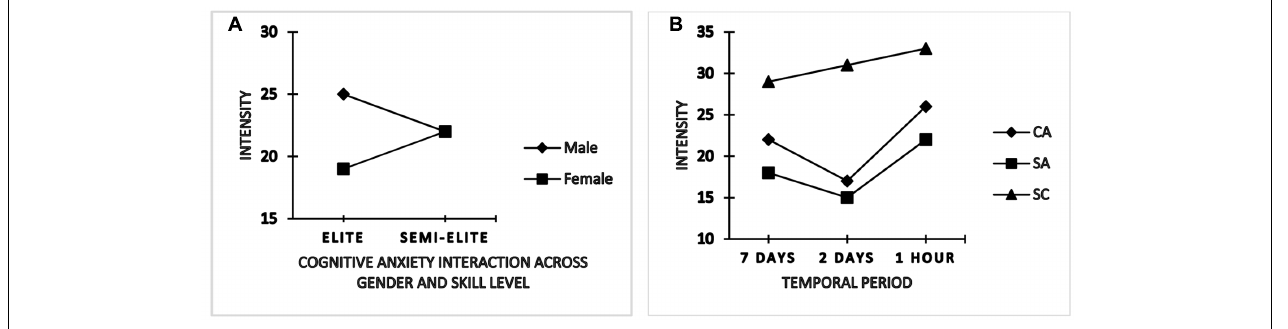
FIGURE 1 | Interaction and time-to-event anxiety and self-confidence intensity changes.